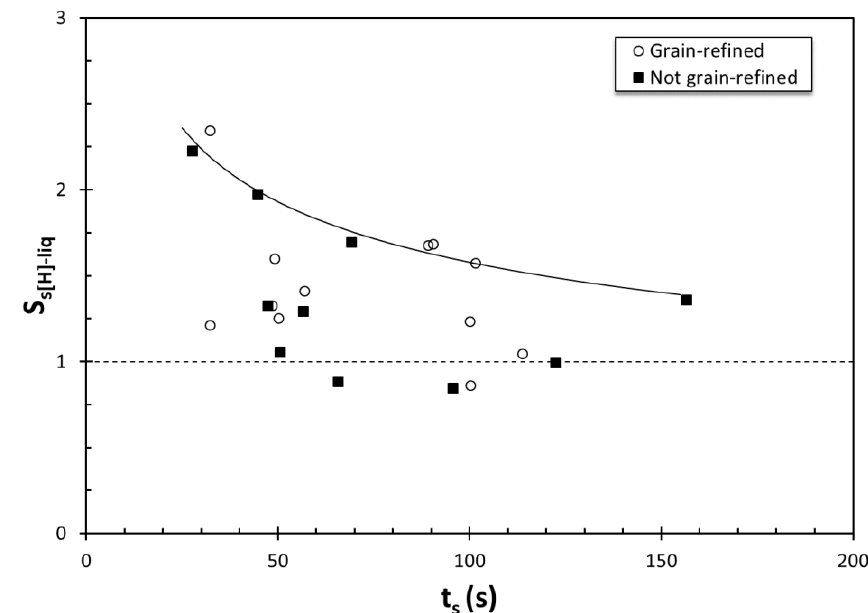
Figure 4. The change in hydrogen supersaturation in an Al-10wt.%Cu alloy at the formation of the first hydrogen pore, with solidification time, with and without grain refining additions (data from Ref. [65]).